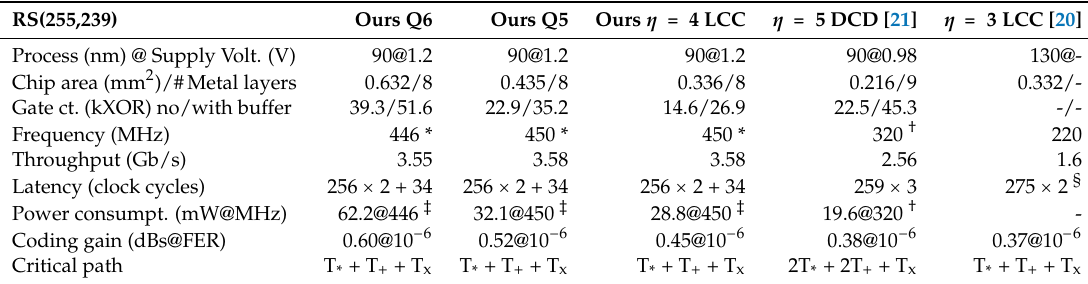
Table 2. Implementation results of RS decoders in CMOS ASICs.